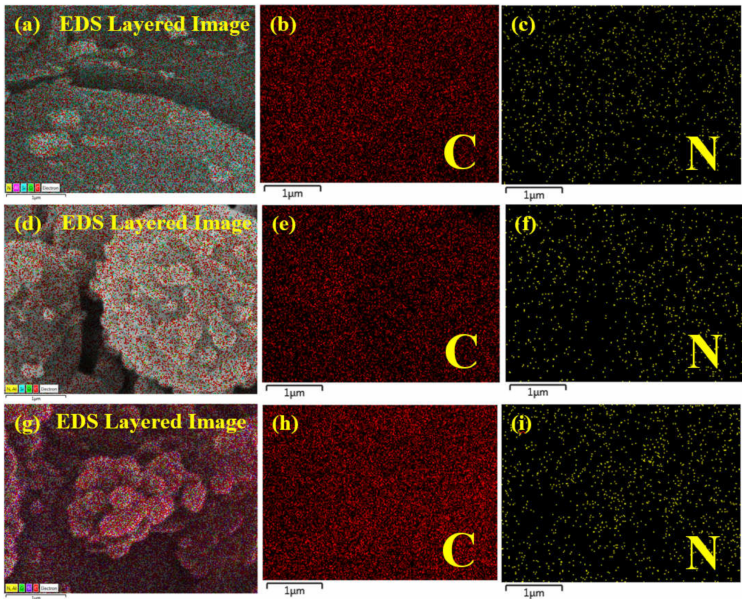
Figure 7. Elemental mapping of ( a – c ) M-50, ( d – f ) M-100 and ( g – i ) M-200